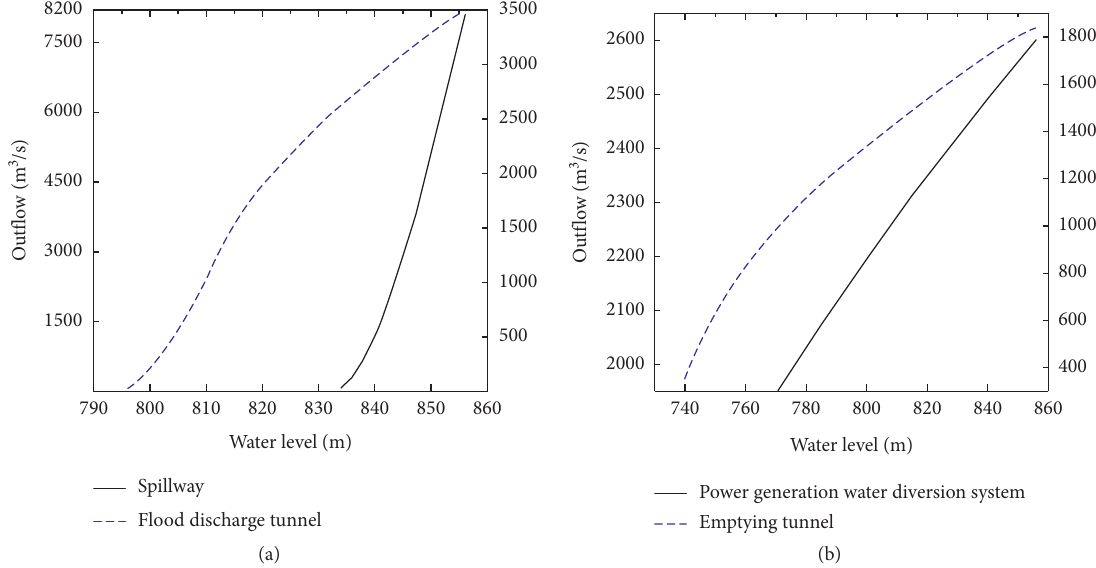
Figure 9: The discharge curves for release structures of the PBG hydropower station.